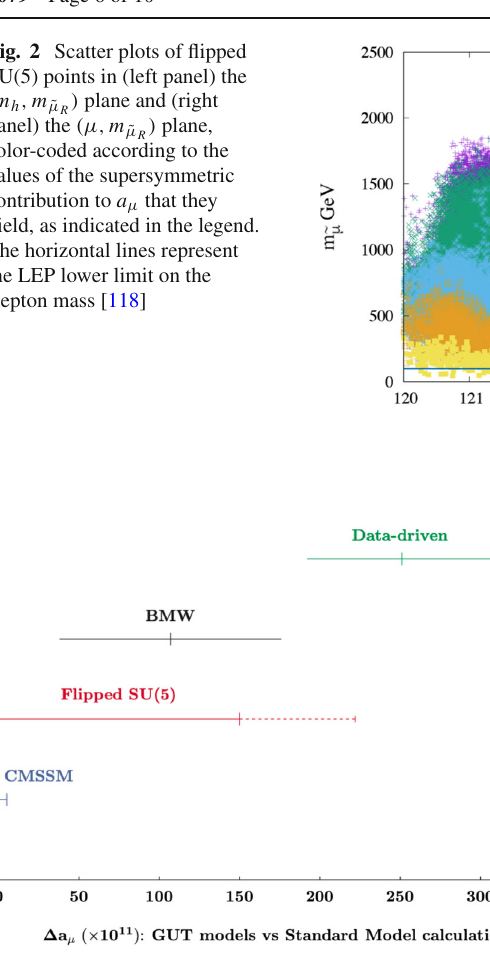
Fig. 3 Comparison of the ranges of the discrepancy in a μ between the combination of the BNL and Fermilab measurements with the data- driven estimate taken from the Theory Initiative [4–12] (green line), from the BMW lattice calculation [75,76] (black range), and the ranges found in flipped SU(5) in this paper (red range, general region shown as solid line, extension in exceptional region shown dashed) and in the CMSSM [42] (blue